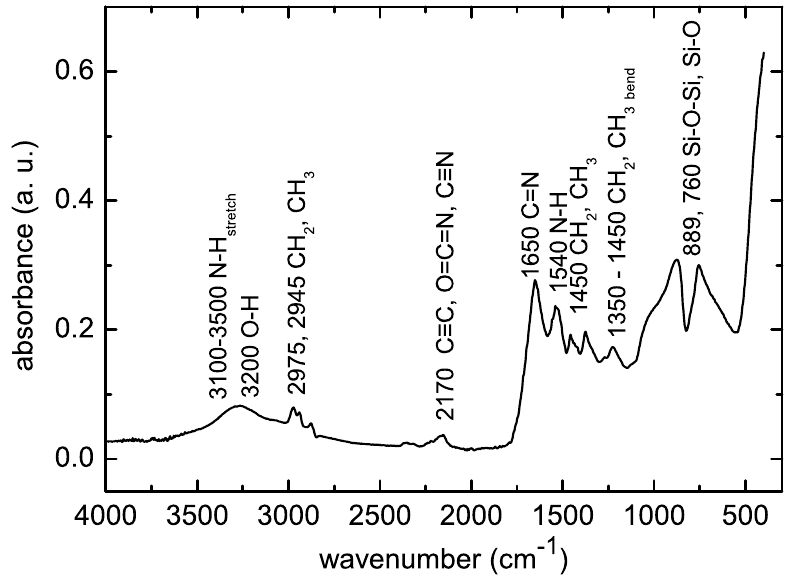
Figure 7. FTIR spectrum of POx thin film deposited at the substrate temperature of 90 ◦ C.